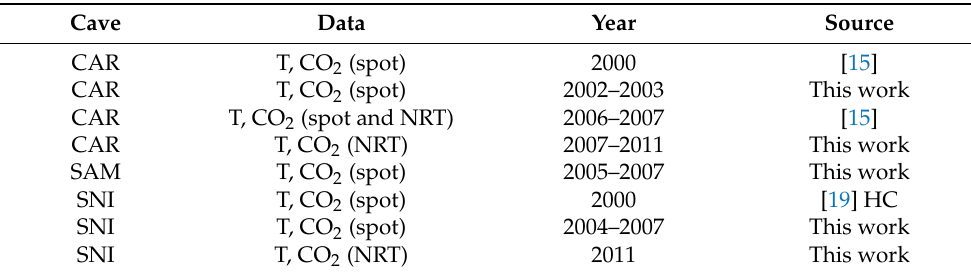
Table 1. Source of data used in this study. CAR, SNI, and SAM are Carburangeli, Santa Ninfa, and Sant’Angelo caves, respectively; T is temperature; NRT is Near-Real Time; HC is hardcopy only, in Italian, not available online.